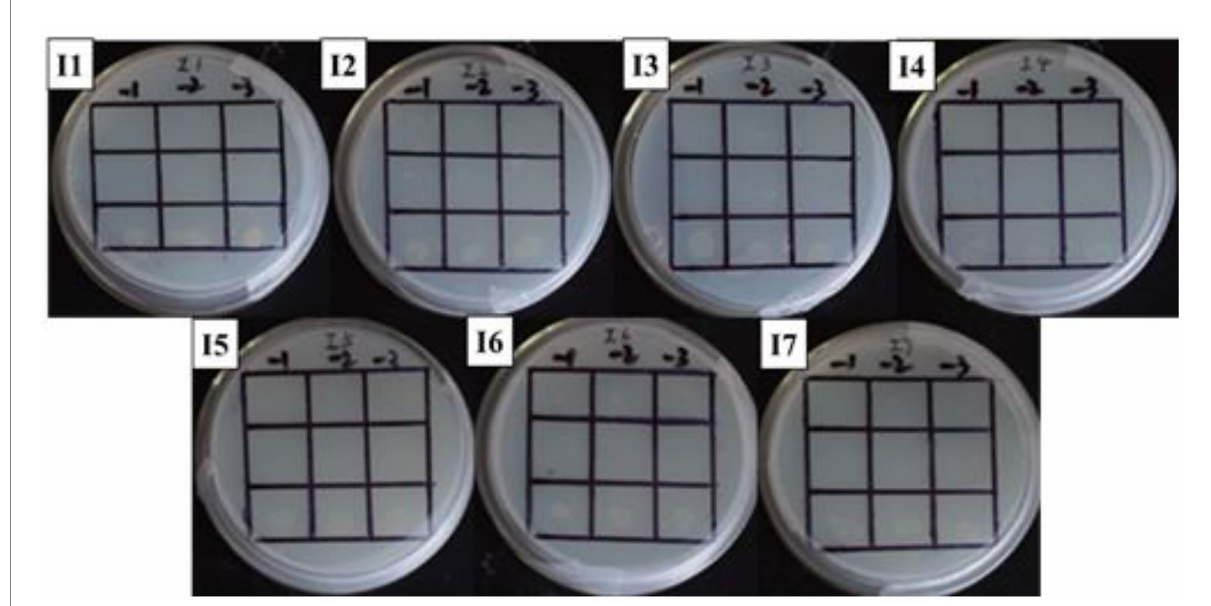
FIGURE 5 Positive sieve plate with histidine, 0 μ g/ml NaNO 2 (I1), 20 μ g/ml NaNO 2 (I2), 40 μ g/ml NaNO 2 (I3), 60 μ g/ml NaNO 2 (I4), 80 μ g/ml NaNO 2 (I5), 100 μ g/ ml NaNO 2 (I6) and 120 μ g/ml NaNO 2 (I7). The first row: US0/pH3U3; the second row: US0/pH3U3-pNir; the second row: US1/pH3U3-pNir. − 1, − 2, and − 3 indicate that the three columns of point samples from left to right are 10 − 1 , 10 − 2 , and 10 − 3 in the figure of gradually reducing concentrations of bacterial solution mixed with water.